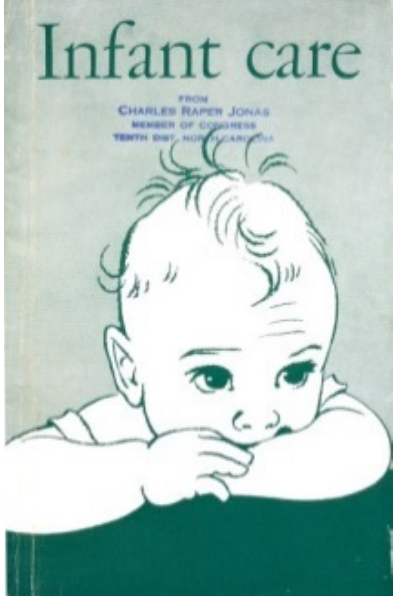
Figure 3. Infant Care Cover—1951—Stamped by Congressman.